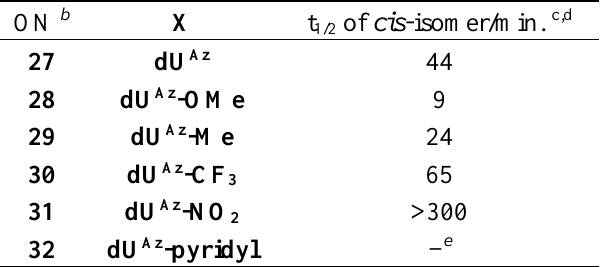
Table 4. Half-life time of the cis -form of para -substituted- dU Az at 60 °C a .